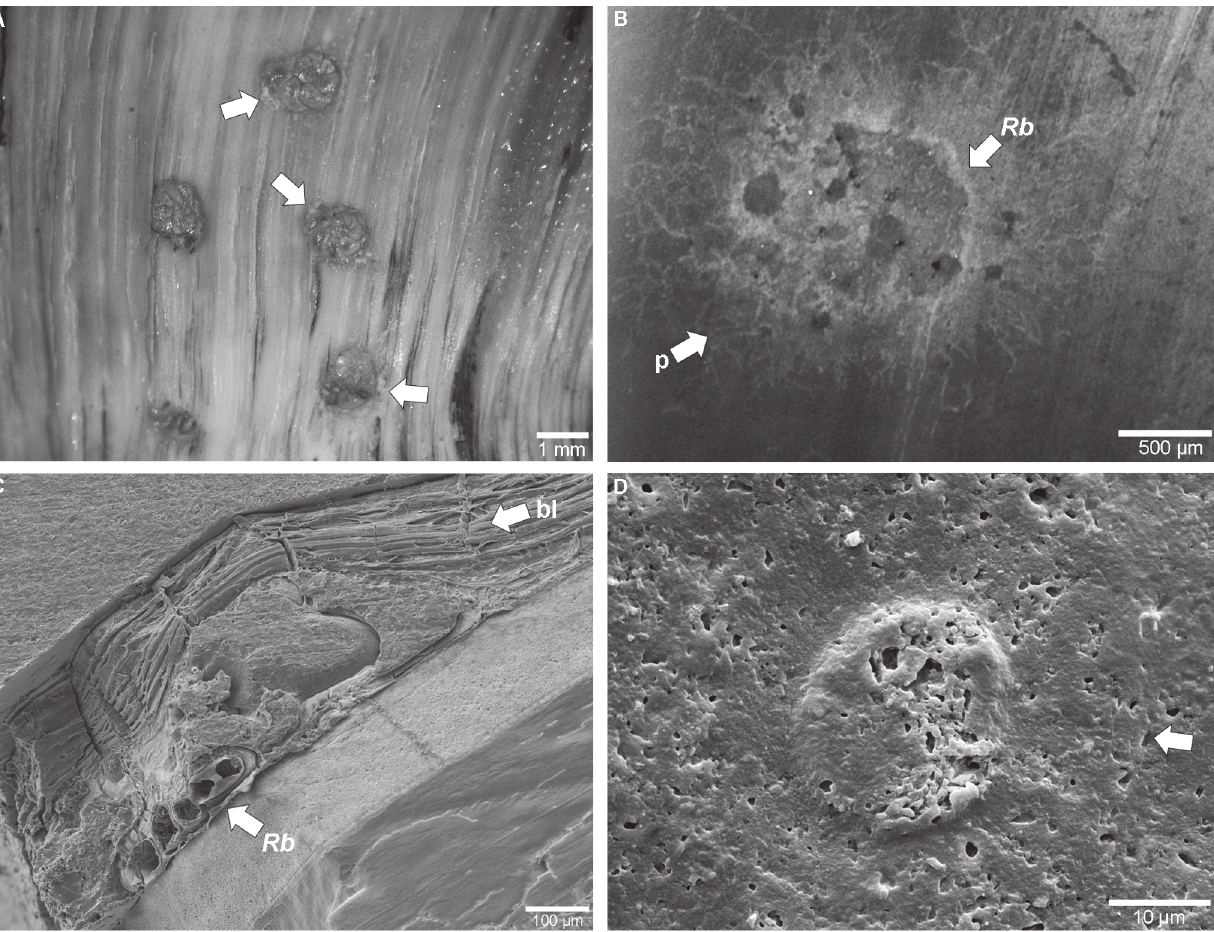
Fig 3. Attachment scars on the shells of Nautilus macromphalus from New Caledonia. (A) Cluster of Rosalina bradyi attached to the shell of specimen AMNH 93433. (B) Attachment scar of R . bradyi (Morphotype 1) ( Rb ) on the shell of specimen AMNH 93431; remains of the fringe of pseudopodia indicated with 'p'. (C) SEM image of R . bradyi ( Rb ) attached to the Nautilus shell and overgrown by the black layer (bl). (D) SEM image of epoxy resin casts showing an attachment scar (Morphotype 2) of a foraminifer specimen with affinity to Gypsina vesicularis ; the center displays a spiral morphology that is surrounded by a circular depression (arrow) (specimen AMNH